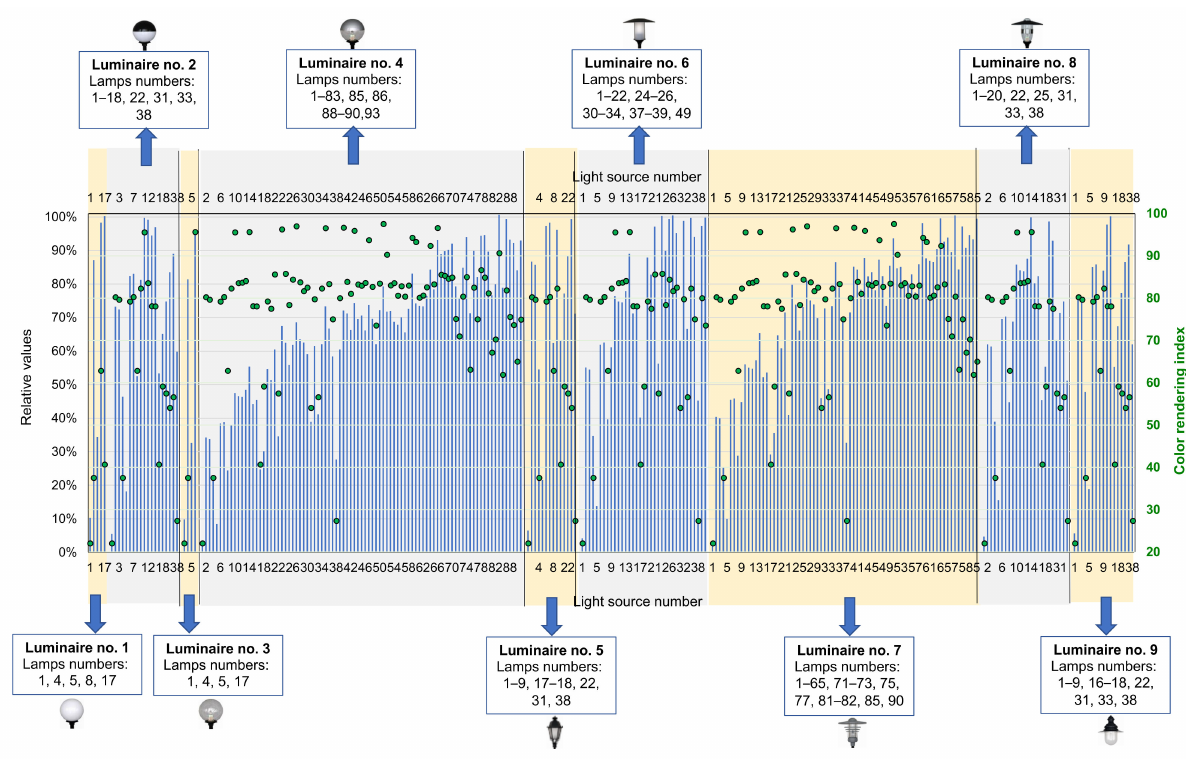
Figure 17. Set of LED sources for which the values of LP do not exceed 100.6%.